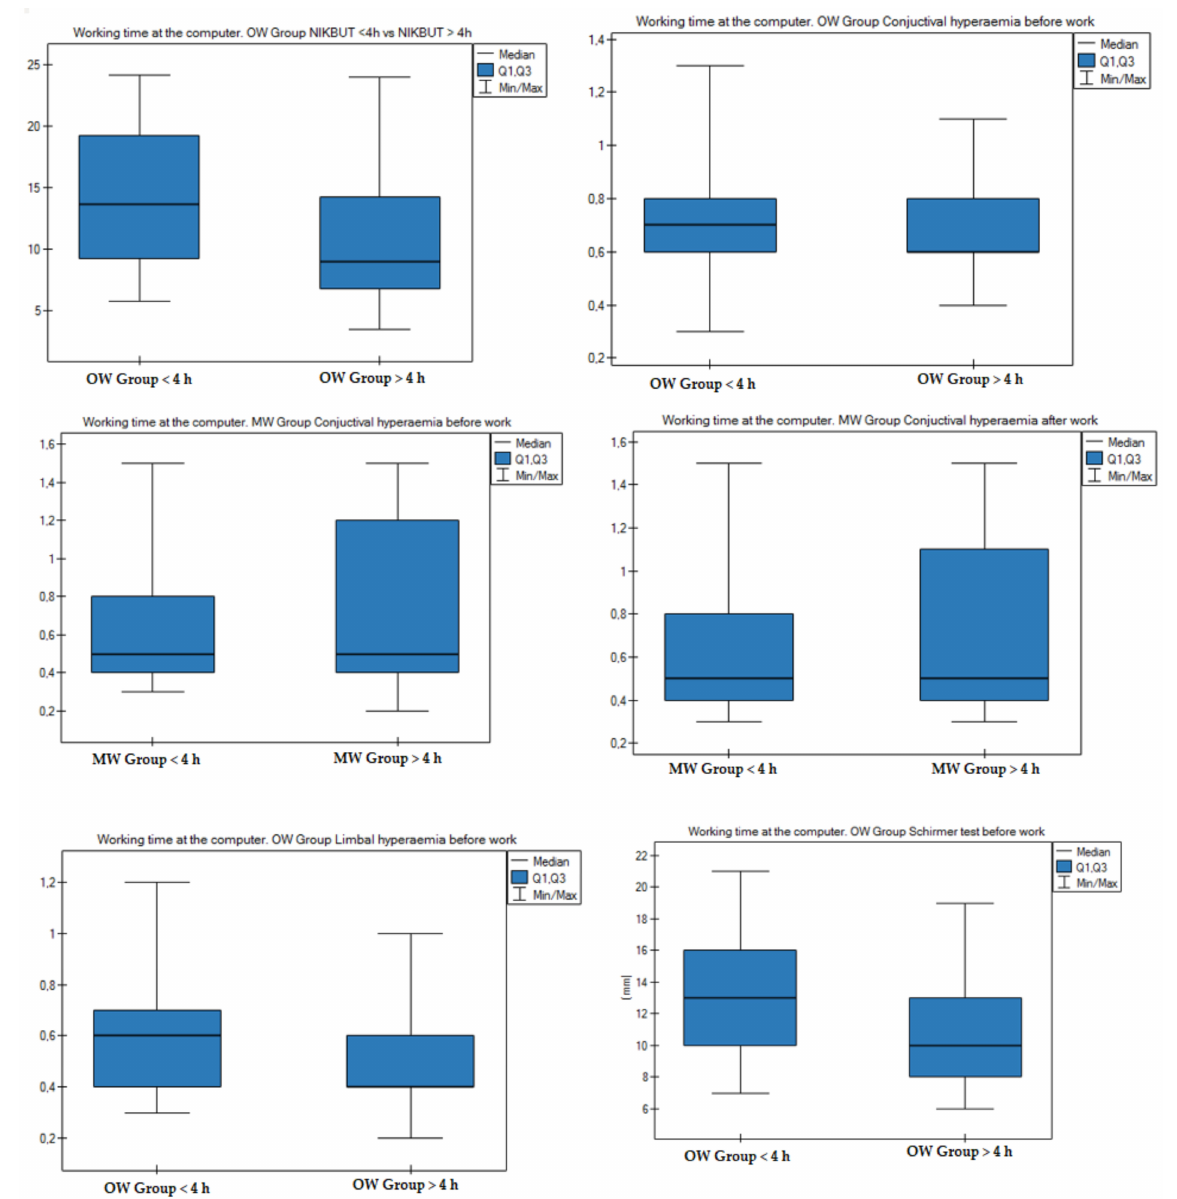
Figure 6. Working time at the computer and the results of measurements of the eye surface parameters in the OW and MW groups. Table S4 is available in the Supplementary Materials.